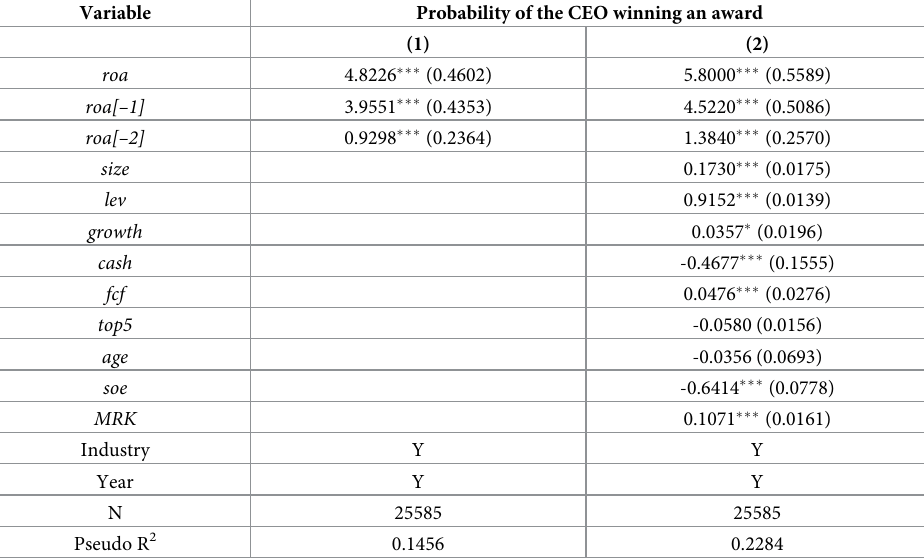
Table 4. Firm performance and the probability of CEOs winning awards.